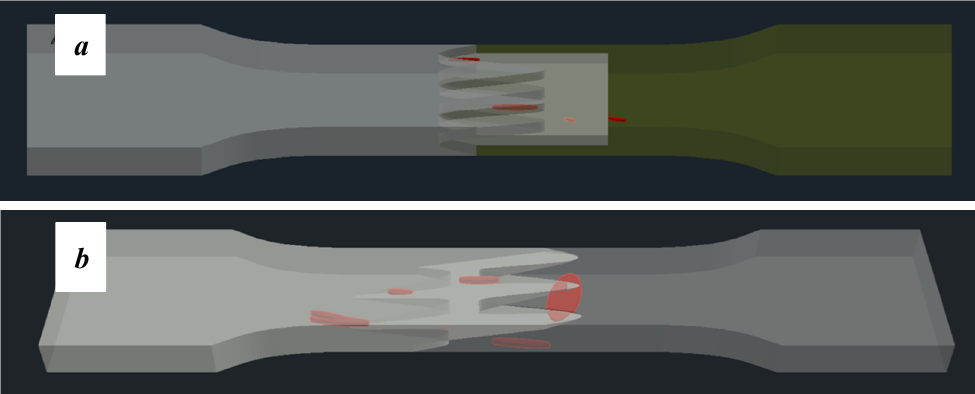
Figure 9. Three-dimensional (3D) model of samples with defective areas designation; ( a ) pleated connection, PLA Though™, and ABS; ( b ) overlap connection, PLA Though™, and ABS.